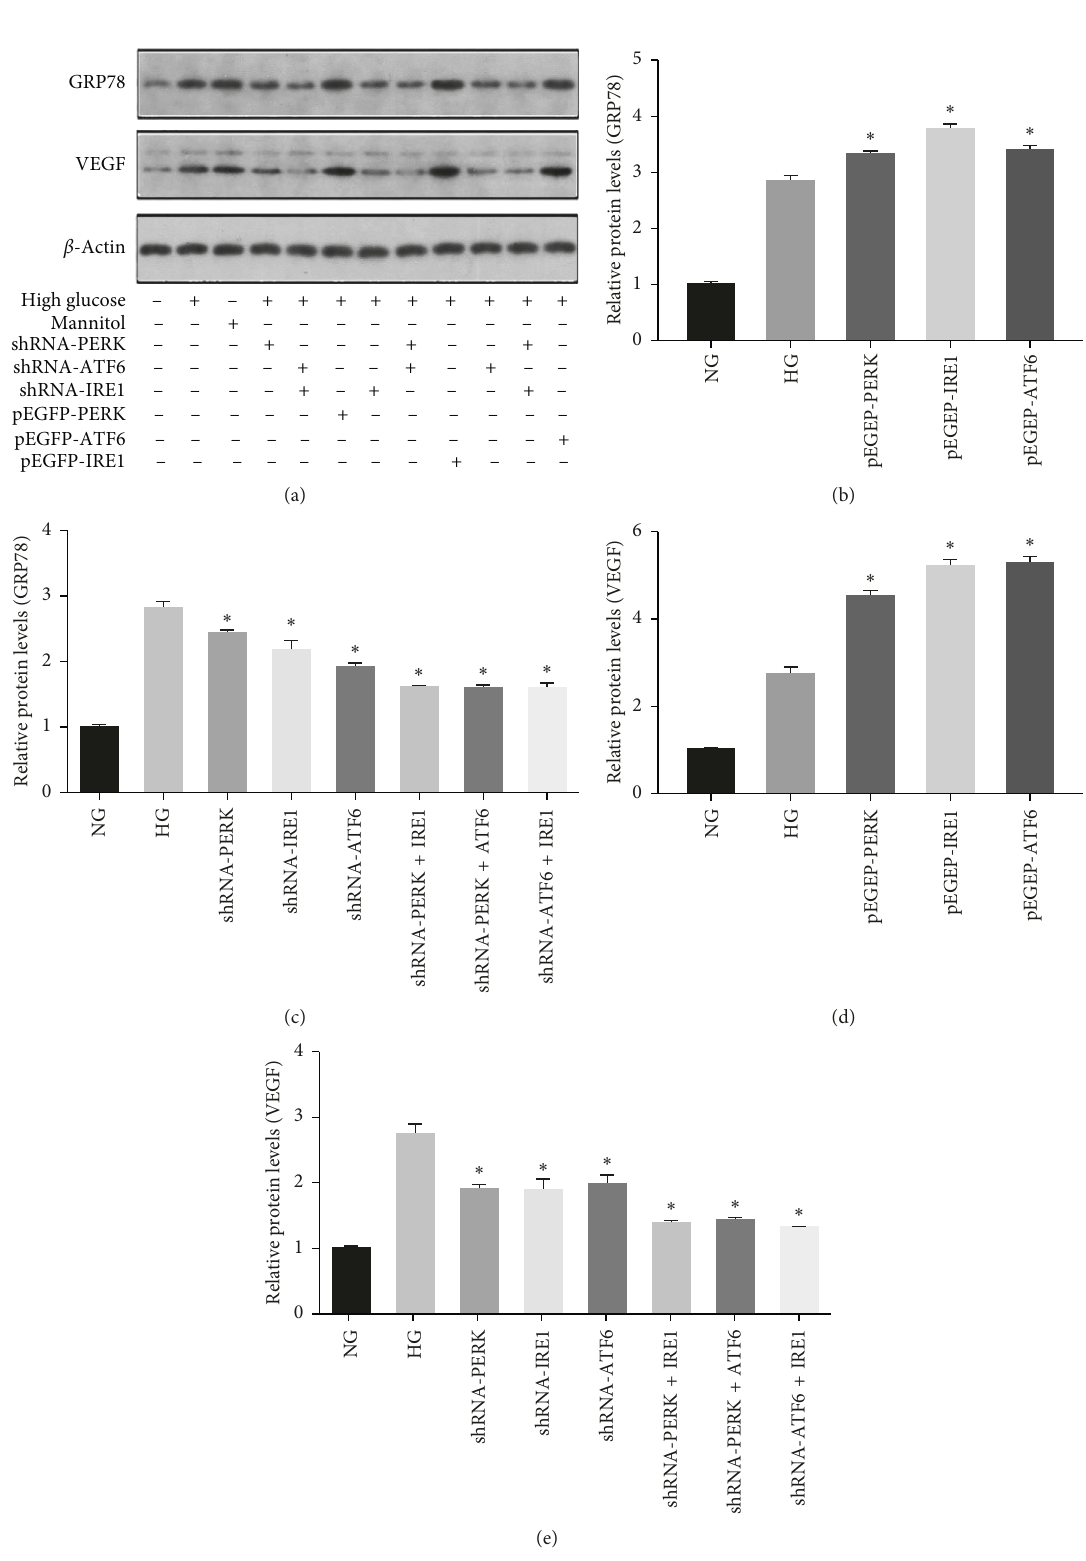
Figure 7: GRP78 and VEGF in rMCs transfected with shRNAs or overexpression plasmids. The expression levels of GRP78 (a, b, c) and VEGF (a, d, e) were measured by western blot analysis. Representative blots from 3 independent experiments ( n � 3; ∗ p < 0 .